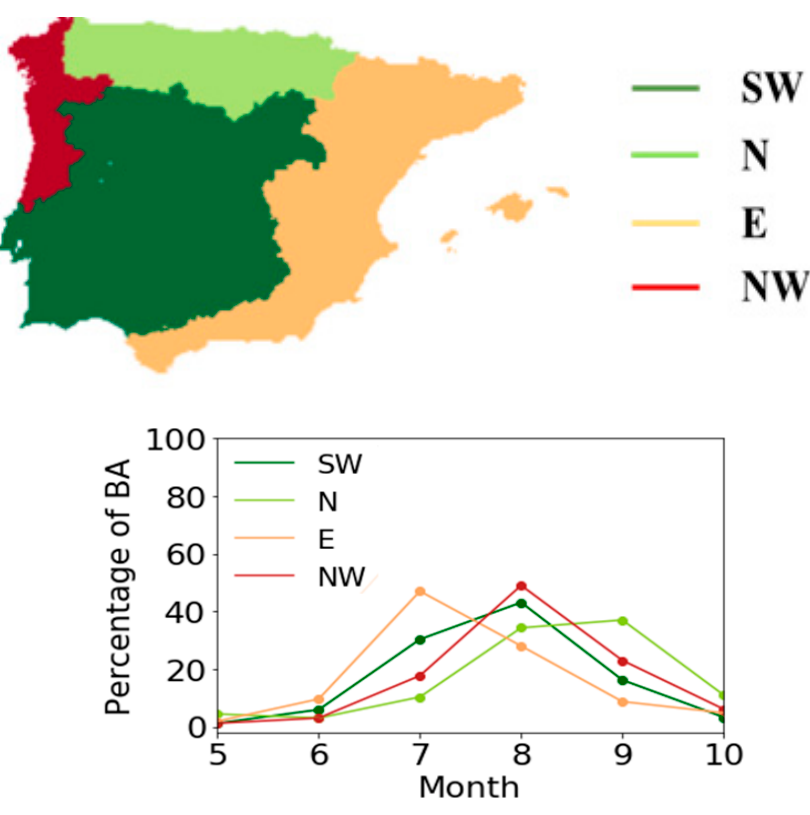
Figure 3. Aggregated study areas (top) and corresponding percentage of burned areas (BA) in the summer